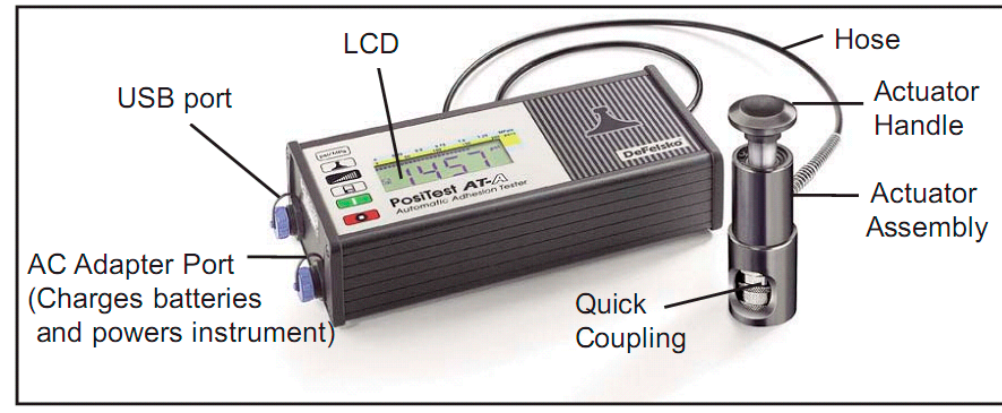
Figure 1. PosiTest ® AT-A automatic pull-off adhesion tester.